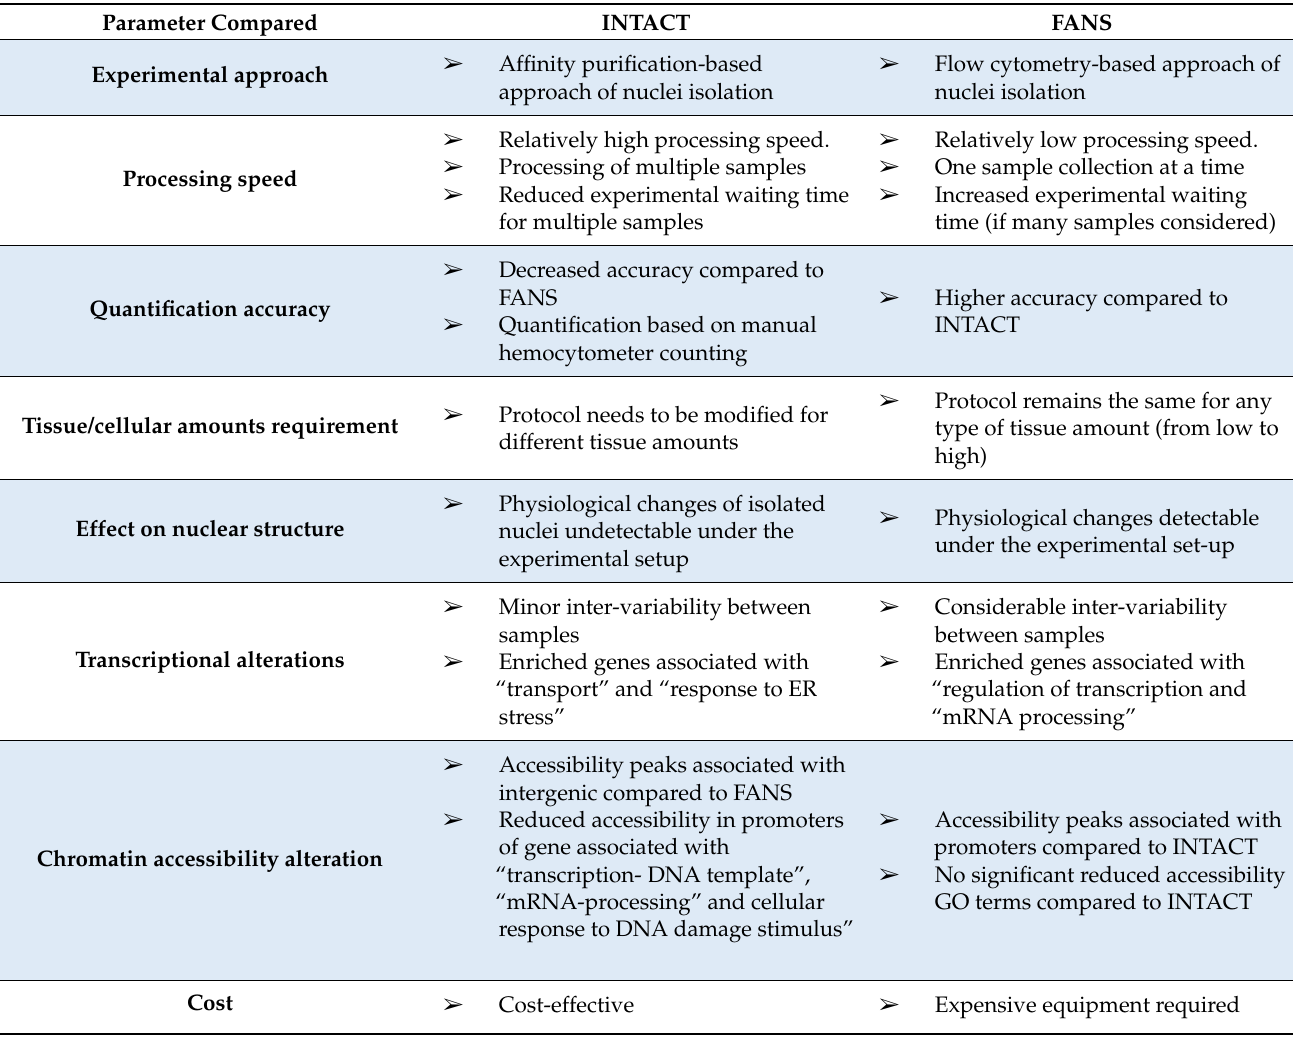
Table 2. Qualitative and quantitative differences between INTACT and